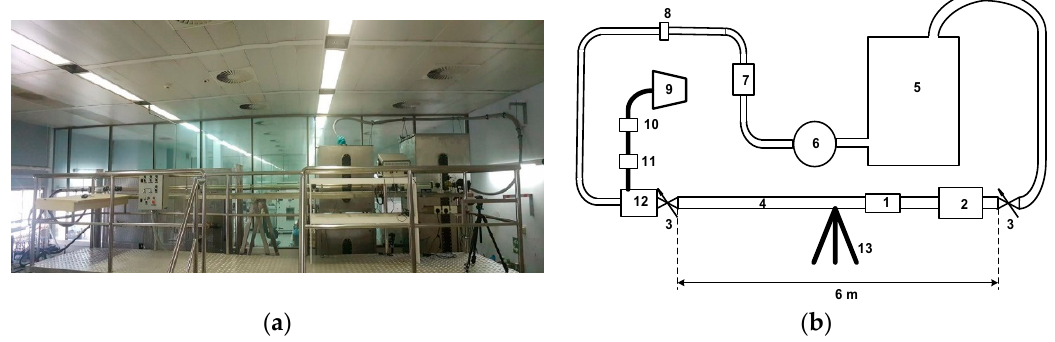
Figure 1. ( a ) Photograph of the flow rig. ( b ) Schematic illustration of the test rig used in the current work. The numbered items are: 1—ECT capacitance sensor, 2—viewing box, 3—fast-closing valves,